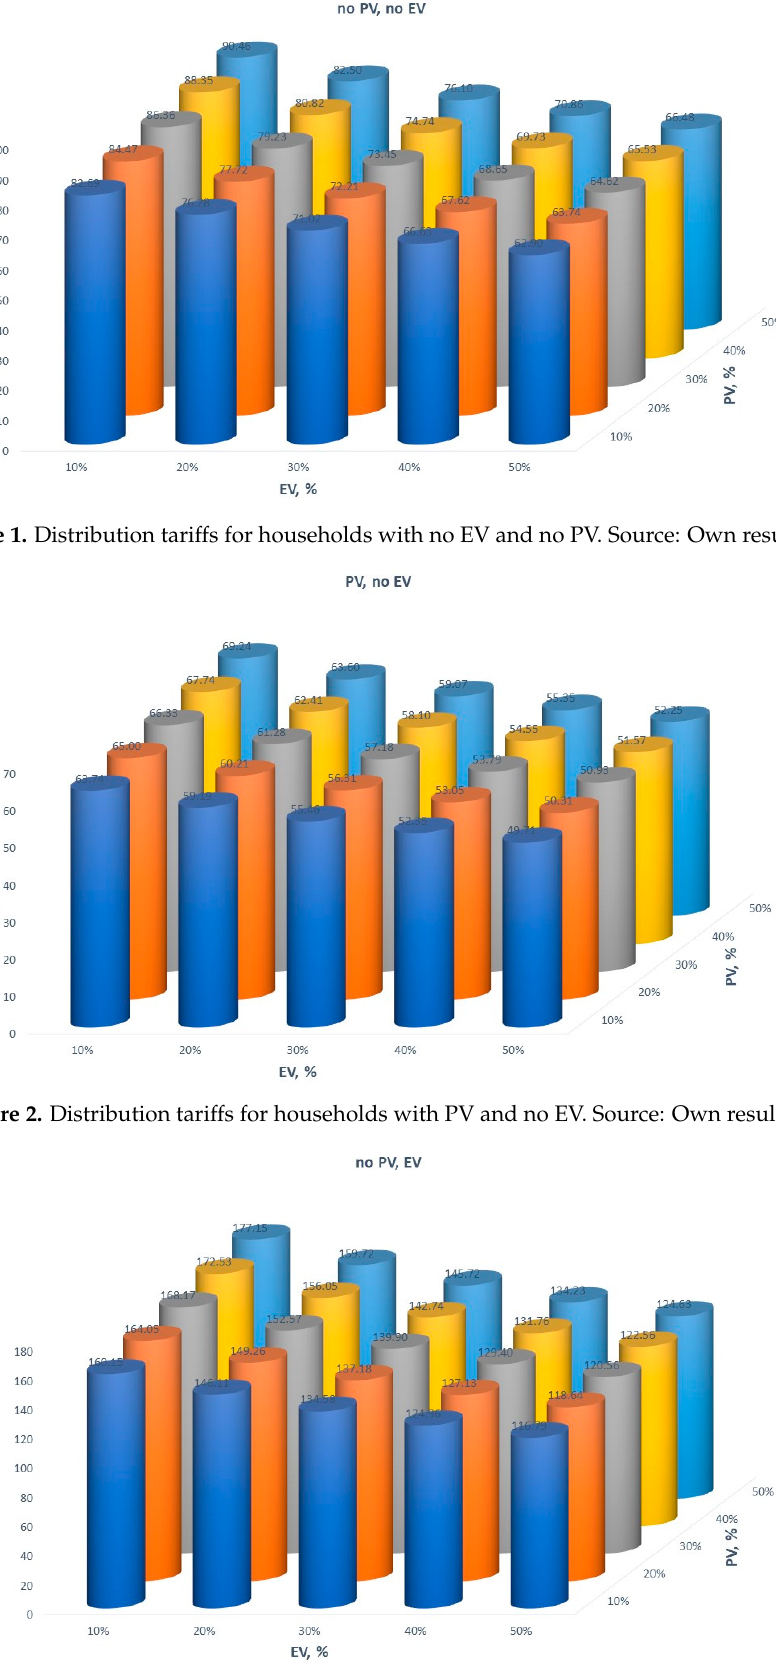
Figure 3. Distribution tariffs for households with no PV and EV. Source: Own